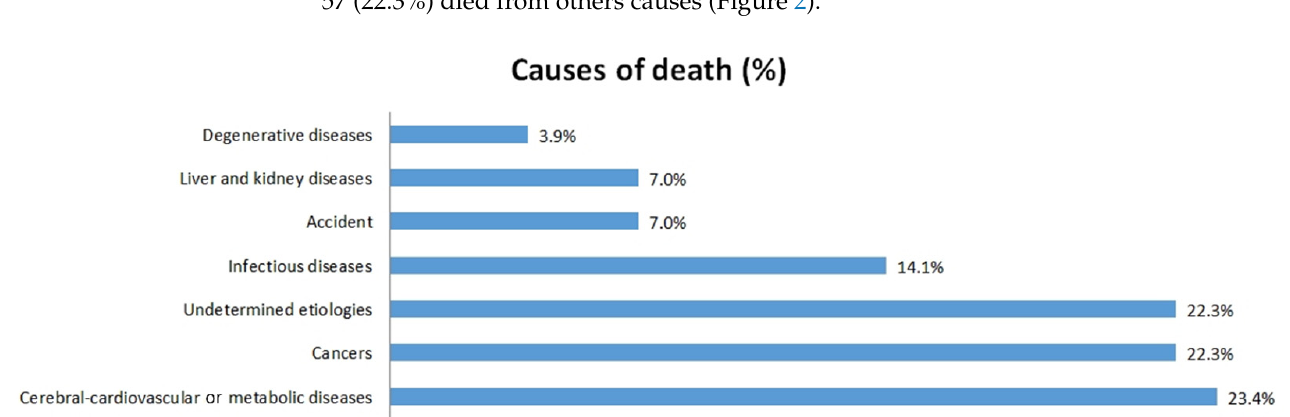
( C ) Figure 1. Kaplan–Meier curve of 5-year mortality rates by BMD of spine and right femoral neck in ( A ) all, ( B ) female, and ( C ) male participants. Group A: BMD of lumbar spine ≥ 0.715 g/cm 2 and right femoral neck ≥ 0.550 g/cm 2 . Group B: BMD of lumbar spine < 0.715 g/cm 2 and right femoral neck ≥ 0.550 g/cm 2 . Group C: BMD of lumbar spine ≥ 0.715 g/cm 2 and right femoral neck < 0.550 g/cm 2 .